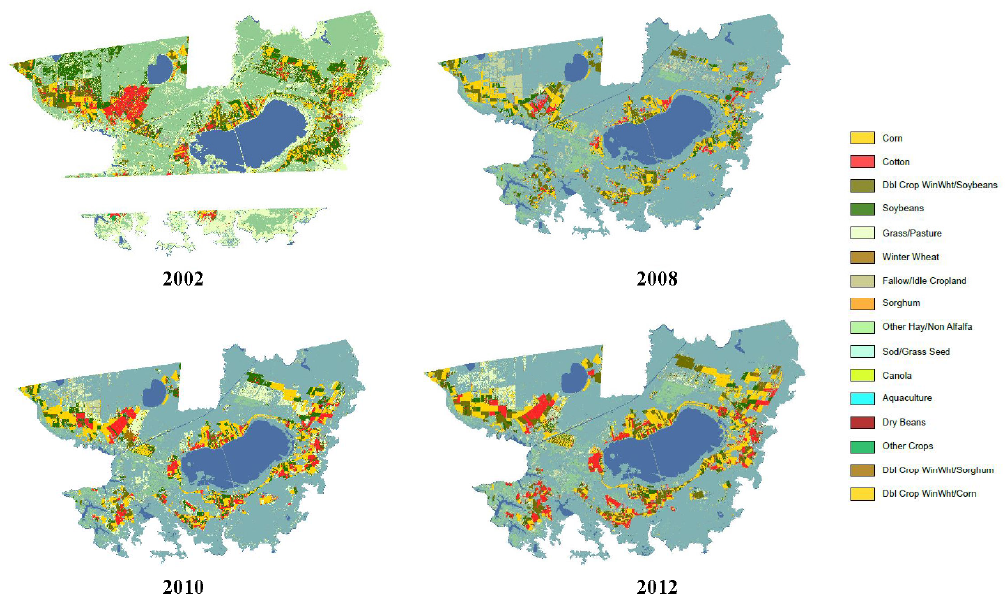
Figure 5. Hyde County, NC agriculture land cover by crop category. Transparent sections contained no data (USDA NASS, CropScape, Cropland Data Layer).